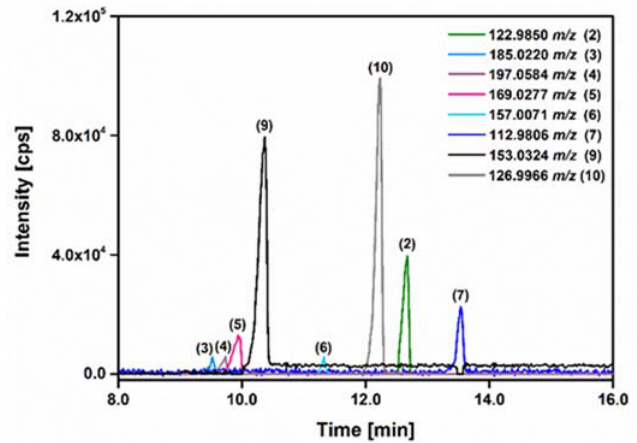
Figure 7. Electropherogram of the OPs in the aged electrolyte sample containing TEP and PS.